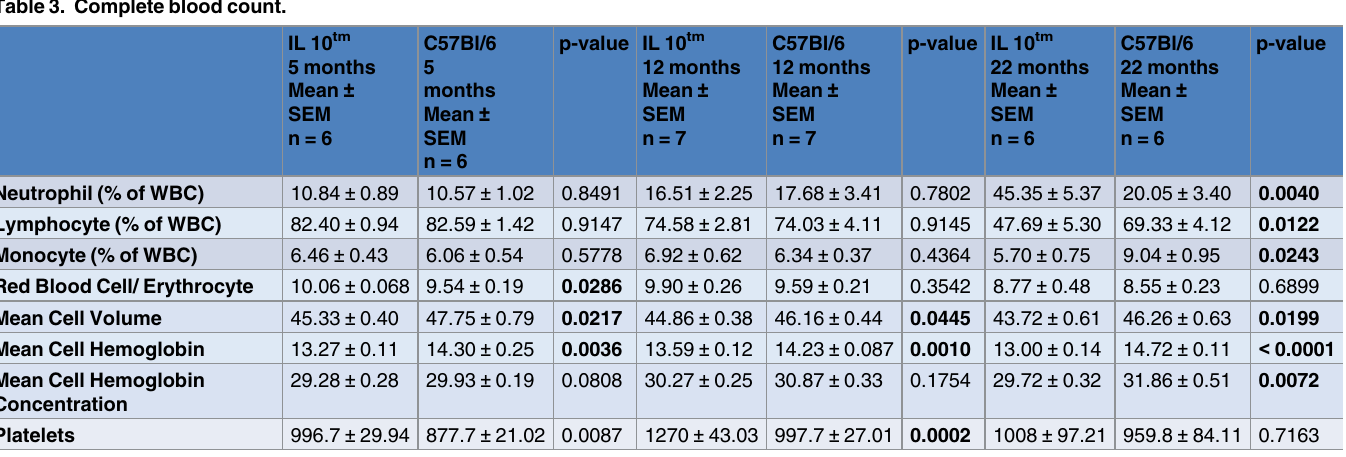
Table 3. Complete blood